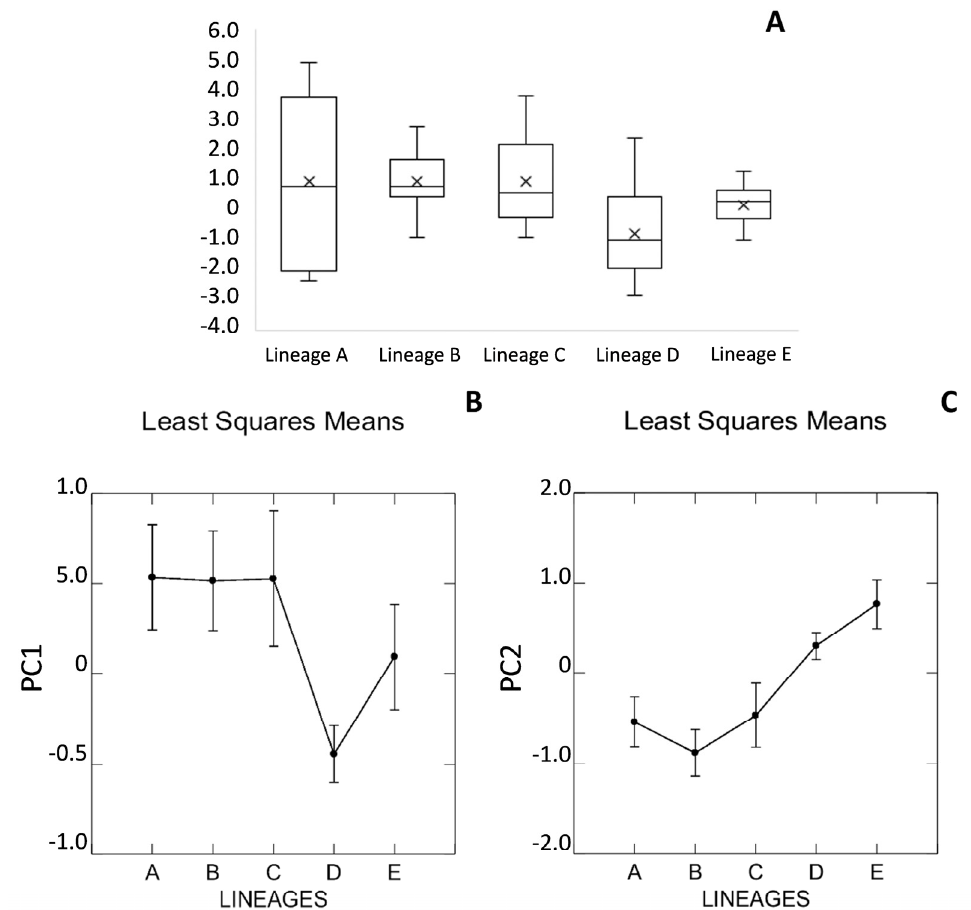
Figure 7. ( A ) . Box plot of the scores of PC1 of the nine morphometric ratios obtained from 71 individuals of each genetic lineage recognized in the DNA-based analyses. X represents the mean, the bottom and top lines represent the 25th and 75th percentiles, respectively, and the bottom and top dashes represent the minimum and maximum values, respectively. ( B ) . PC1 and ( C ) . PC2 represent the first two axes obtained in the PCA (see Materials and Methods for details). Points represent mean values, and the bars represent standard